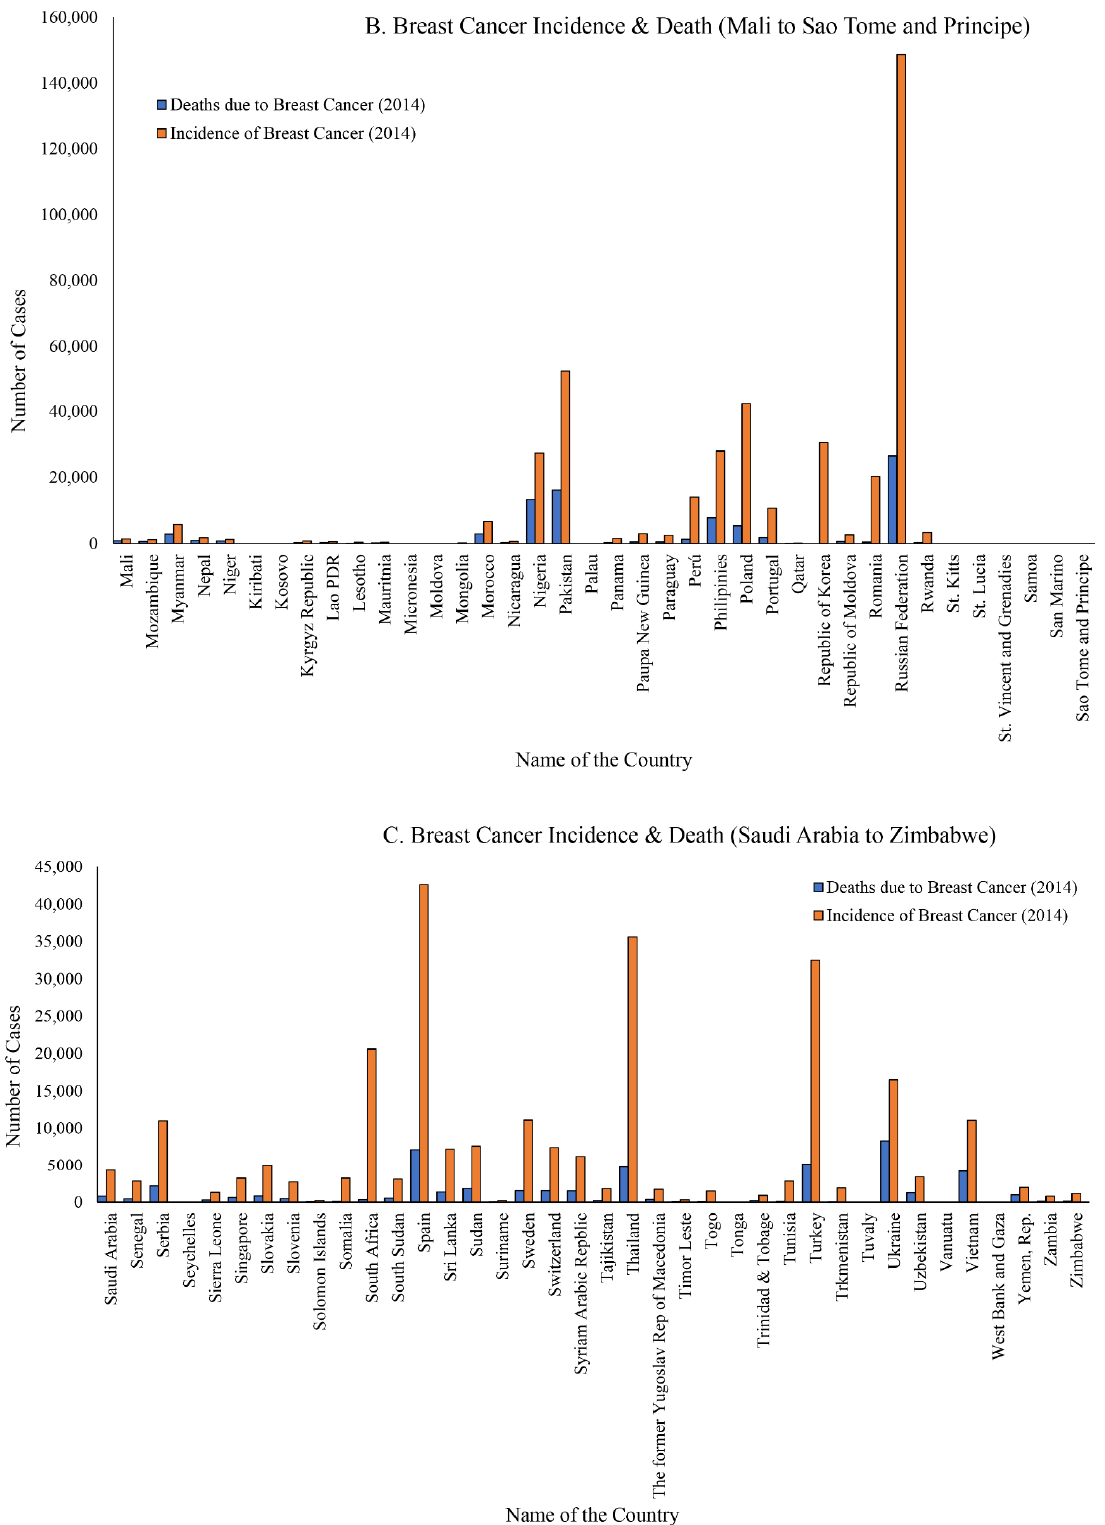
Figure 1. Breast cancer incidence from low- and medium-income countries. The information is collected from each country’s website presented in 2014. ( A ) Breast cancer incidence and death from Armenia to Malawi; ( B ) breast cancer incidence and death from Mali to Sao Tome and Principe; and ( C ) breast cancer incidence and death from Saudi Arabia to